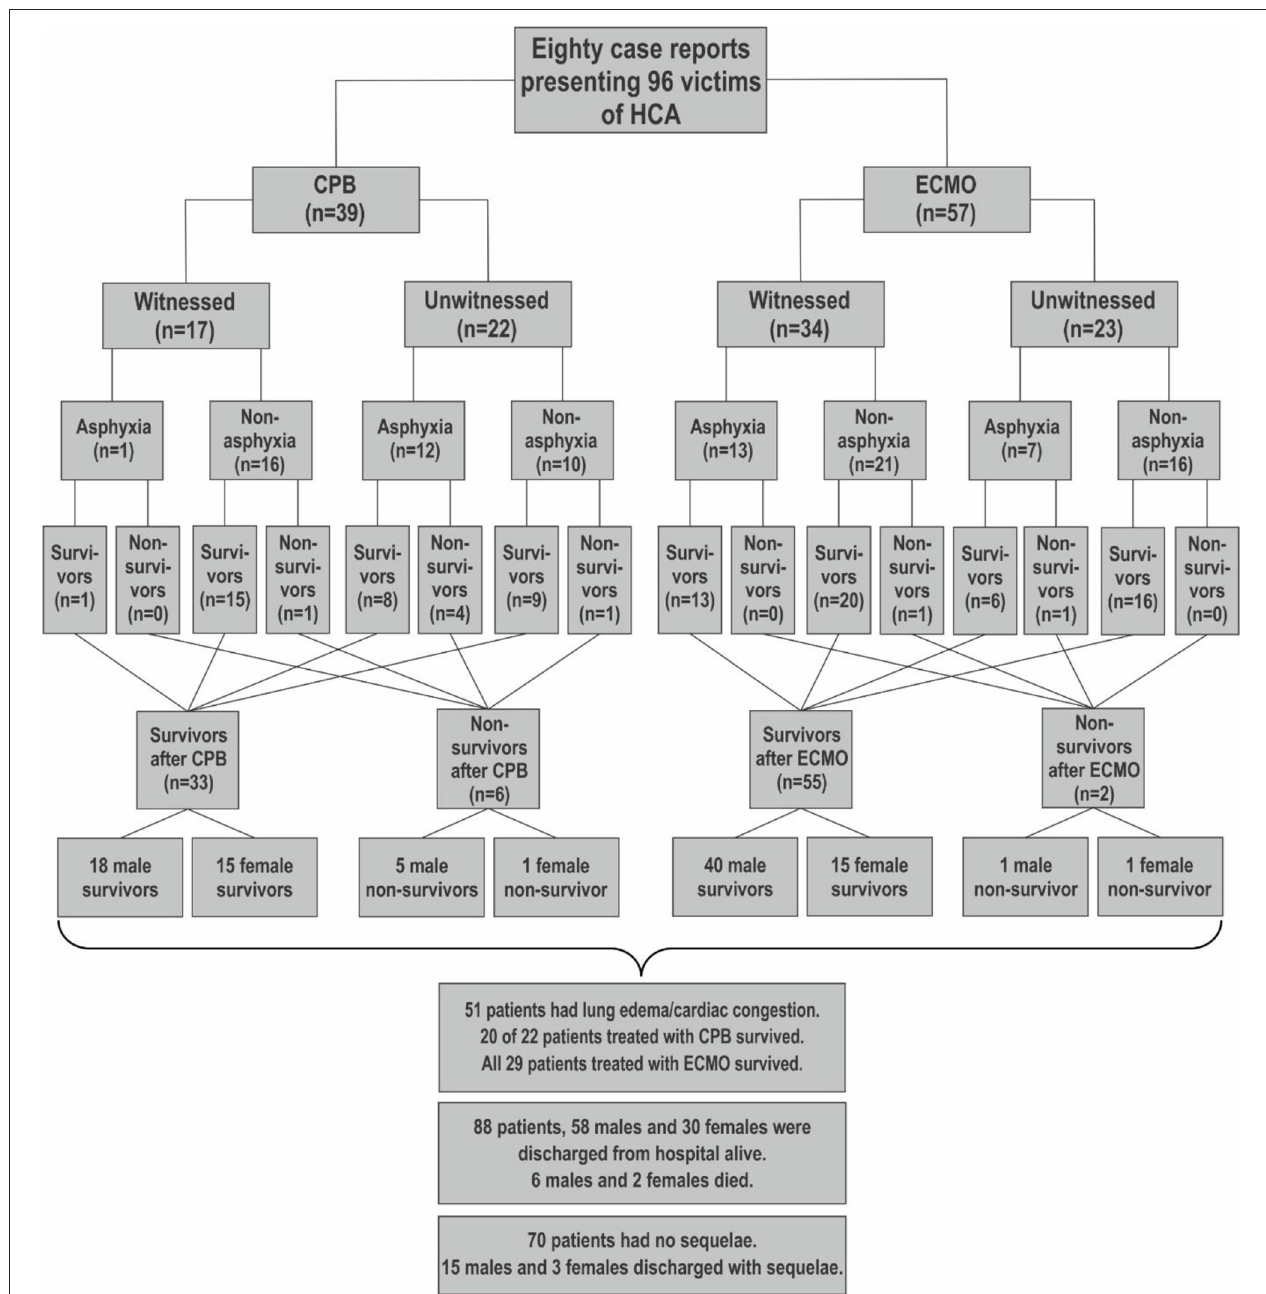
FIGURE 5 | Flowchart surveying 80 case reports with 96 victims of hypothermic cardiac arrest (HCA) rewarmed with ECLS. Thirty-nine patients underwent resuscitation with cardiopulmonary bypass (CPB) and 57 patients with extracorporeal membrane oxygenation (ECMO). We distinguished between witnessed and not witnessed hypothermic cardiac arrest (HCA), whether hypothermia was associated with asphyctic incidents, as drowning or avalanche, or non-asphyctic incidents, as immersion in cold water or exposure to cold environments.